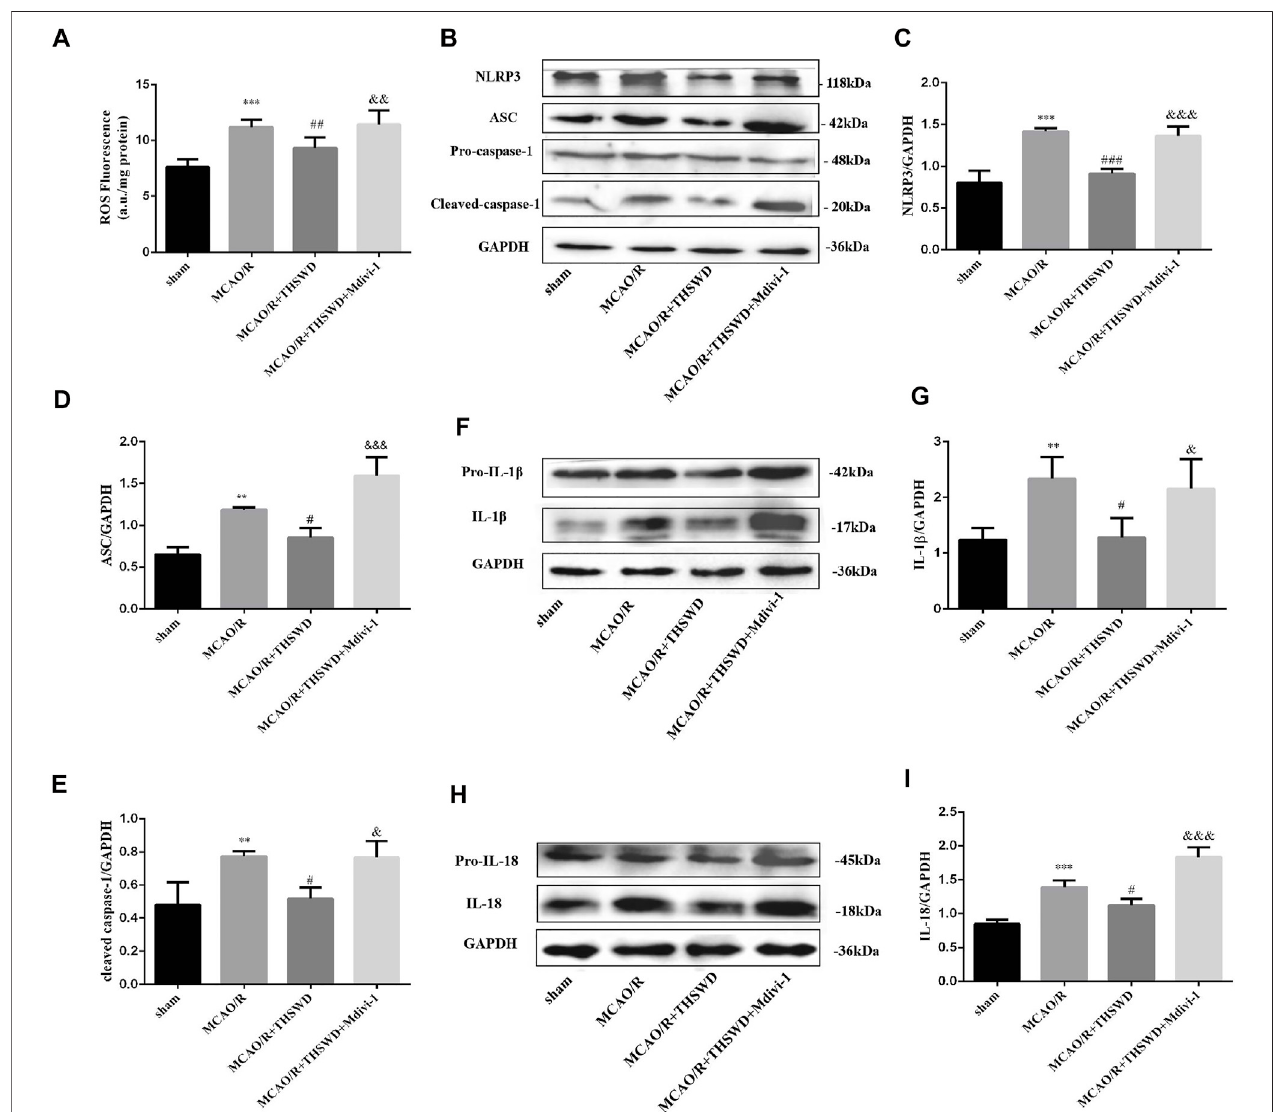
FIGURE5| THSWDtreatmentinhibitsthegenerationtheofROS,activationofNLRP3in fl ammasomeandsecretionofpro-in fl ammatorycytokine. (A) Quanti fi cation of ROS levels; n = 6 per group. (B – I) The Western blot relative band density of NLRP3, ASC, cleaved-caspase-1, IL-1 β , IL-18; n = 6 per group. Each experiment was repeated 3 times. ** p < 0.01, *** p < 0.001 versus sham group, # p < 0.05, ## p < 0.01, ### p < 0.001 versus MCAO/R group, & p < 0.05, && p < 0.01, &&& p < 0.001 versus MCAO/R + THWSD